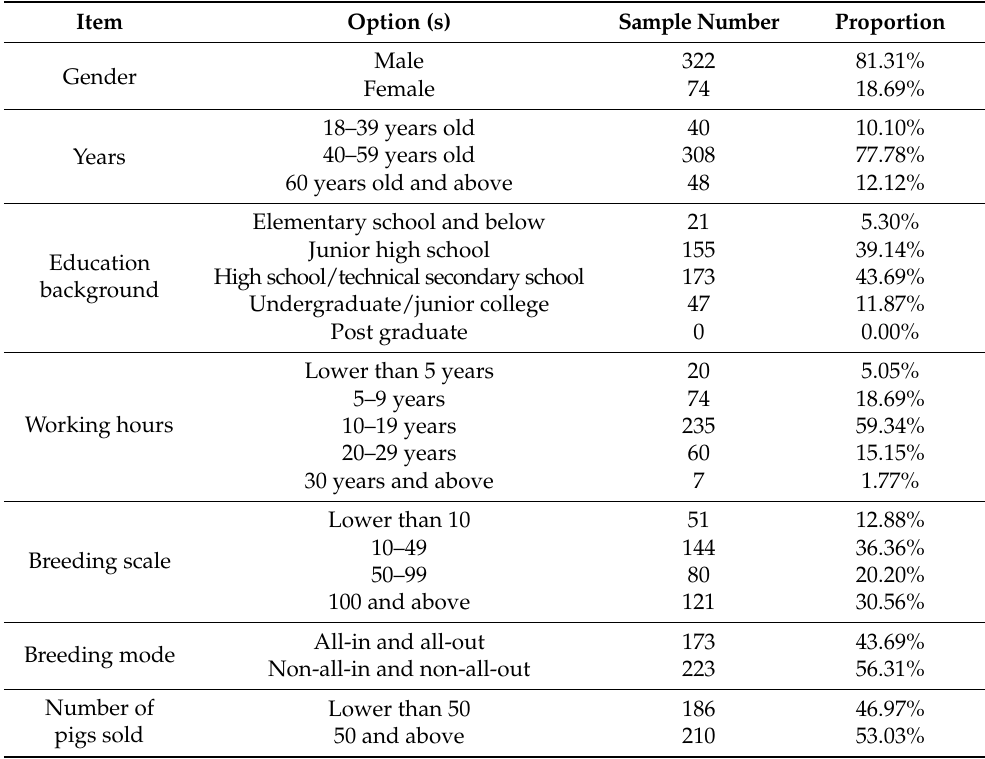
Table 3. Basic characteristics of the